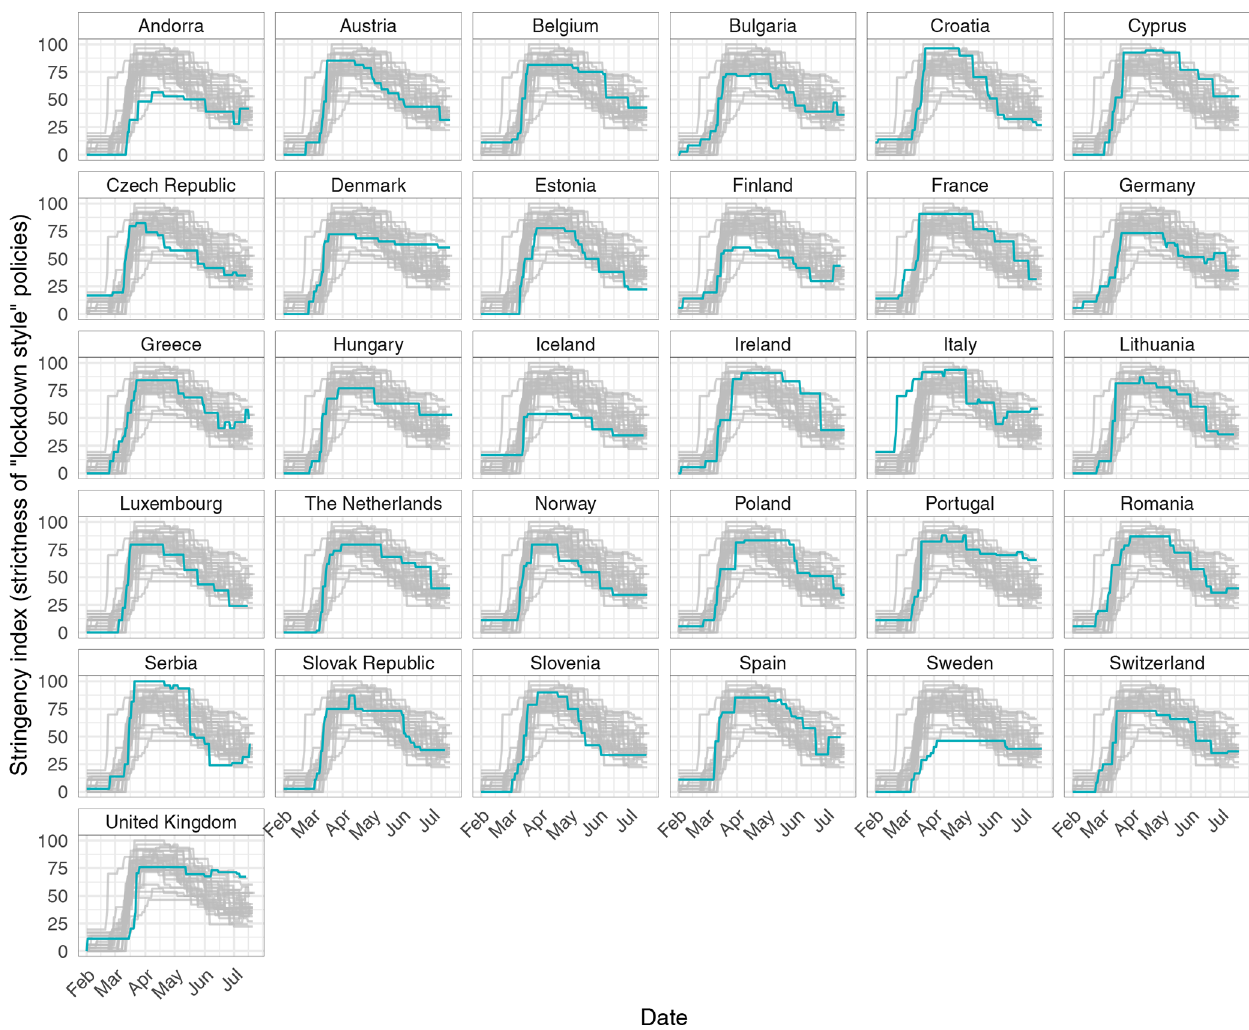
Figure A2. The Oxford COVID-19 Government Response Tracker (OxCGRT) stringency index of COVID-19 lockdown measures imposed by different countries’ governments between February and July 2020 (Hale et al.,